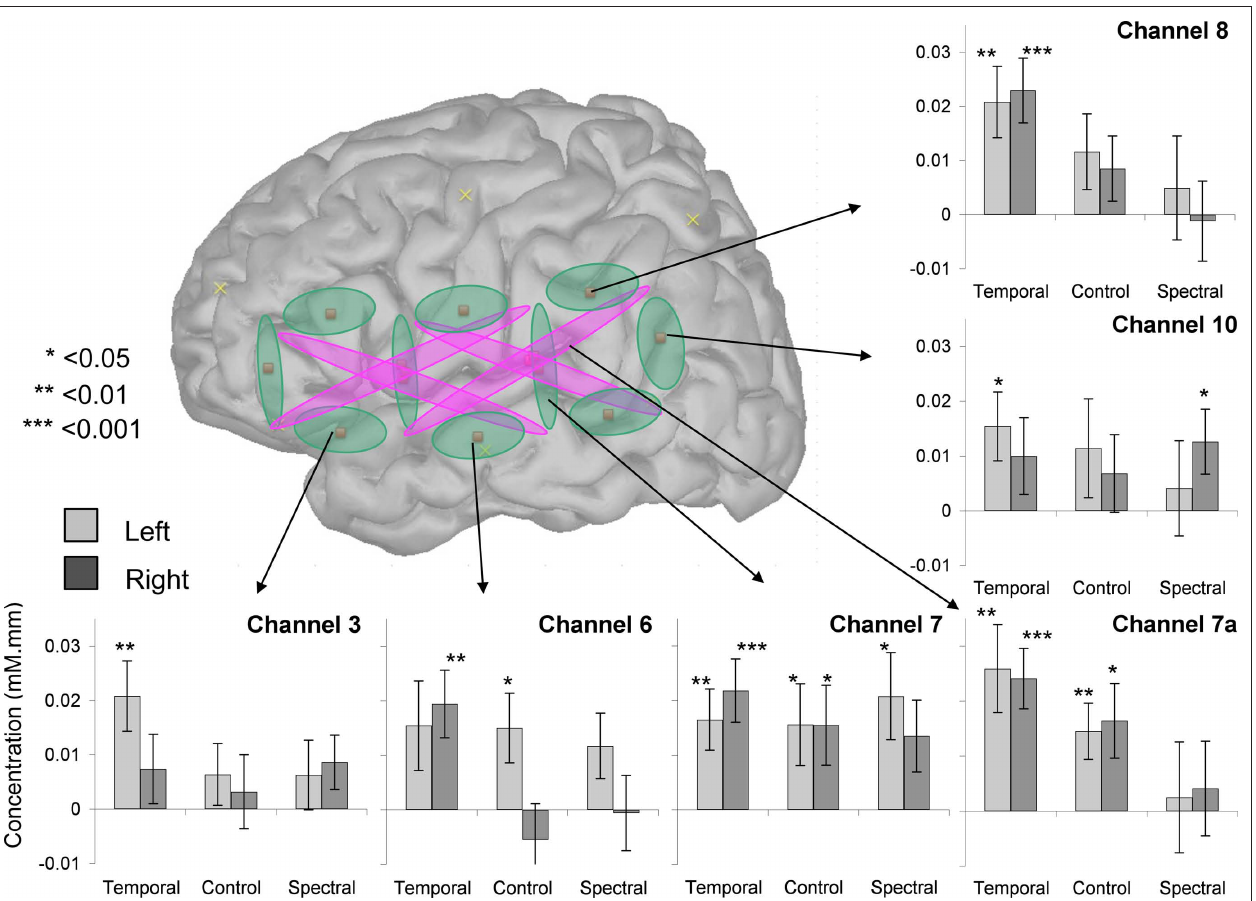
FiguRe 4 | average activation in six target channels. In each bar graph, activation amplitude is indicated as a function of hemisphere